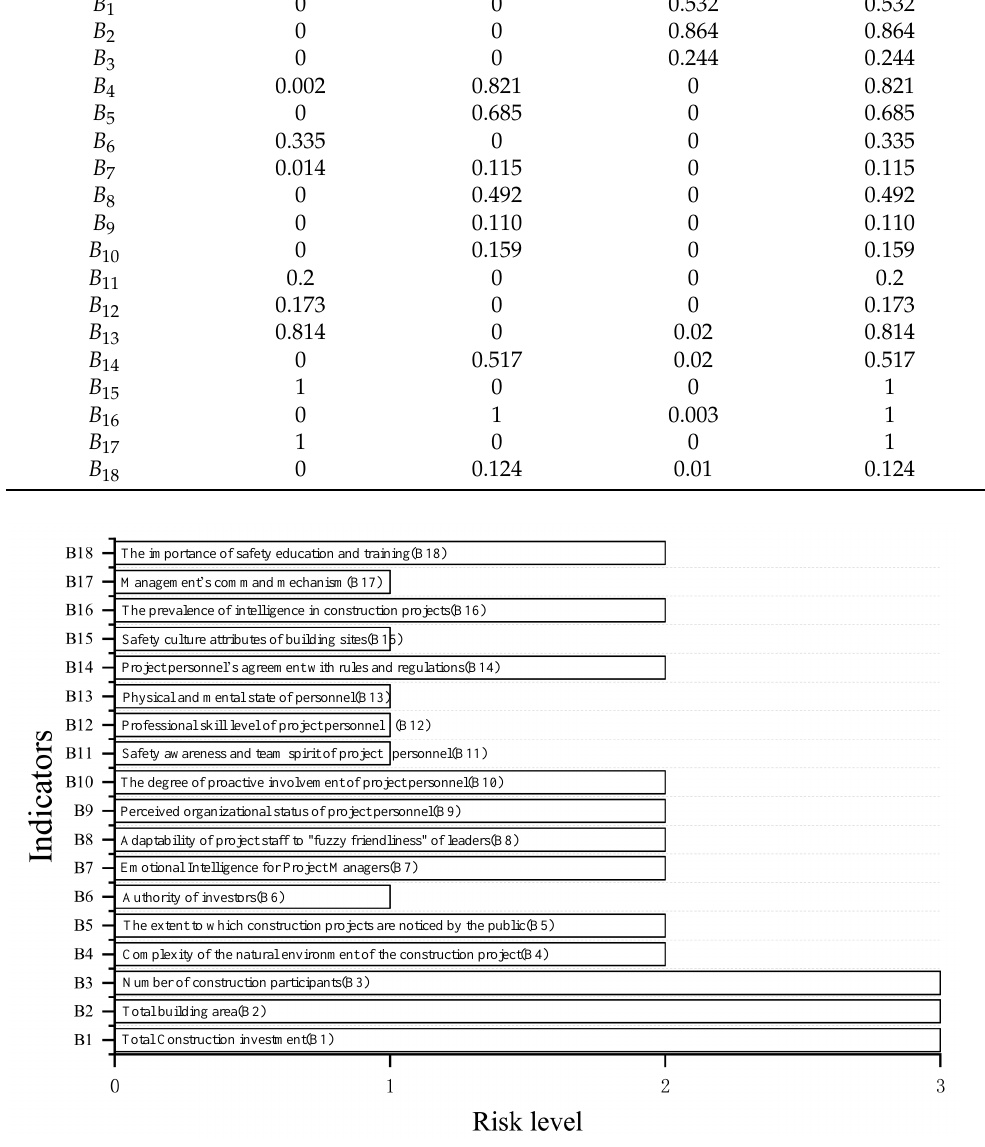
Figure 5. Risk level of each